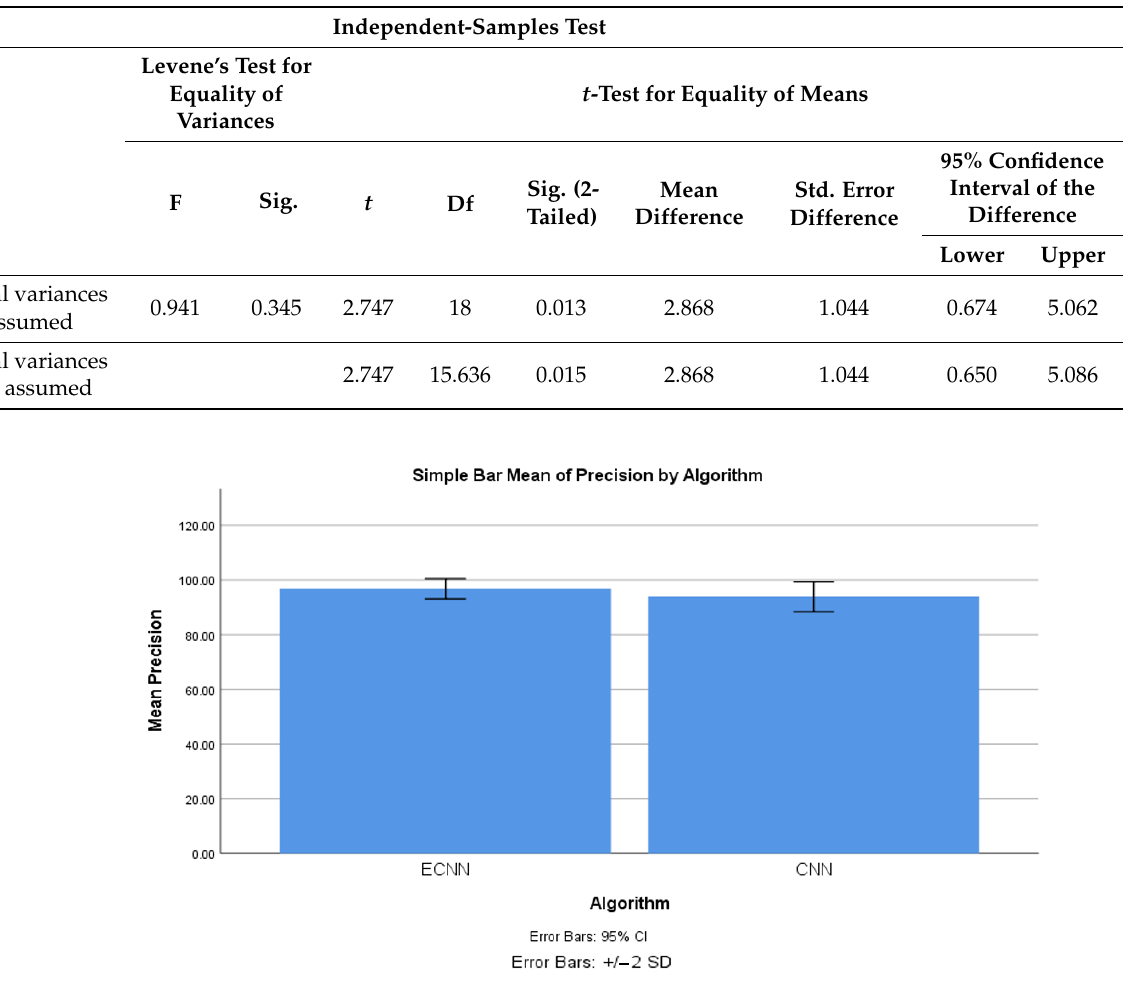
Table 7. Independent-sample test significance computation between ECNN and CNN algorithms for precision.